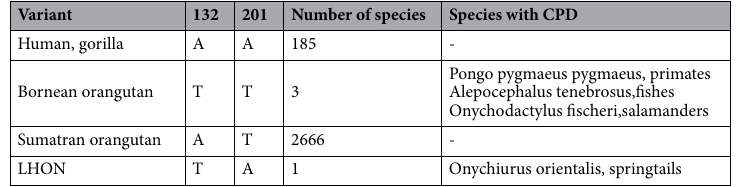
Table 5. Co-occurrence of Alanine (A) and Threonine (T) in sites 132 and 201 of ND1 in our dataset.